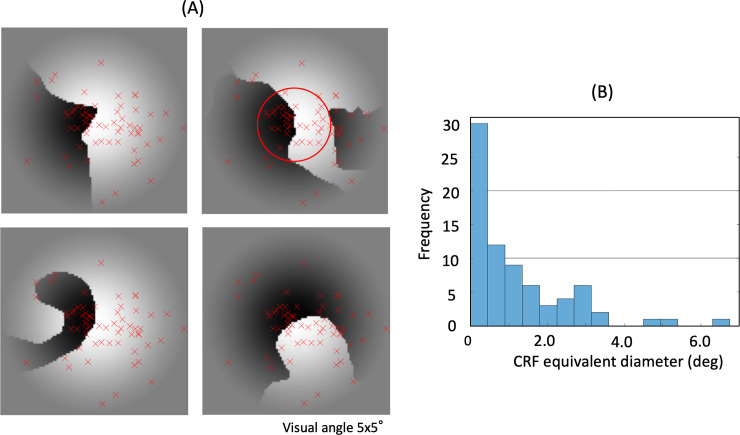
The distributions of CRF center positions and size of recorded neurons for an example single recording session.Each CRF was estimated by fitting a 2D Gaussian to the neural responses. A: The distribution of estimated CRF centers of neurons in an example recording session. CRF centers (red crosses) are overlaid on four example stimulus patches. The red circle at the center illustrates the mean extent of estimated CRFs (1.8 degrees in diameter). B: The histogram of estimated CRF extents of the neurons in the same session. The extent was defined as the diameter of a circle whose area is identical to the area surrounded by the half-height of the 2D Gaussian. The mean estimated diameter was 1.4 degrees in this session.